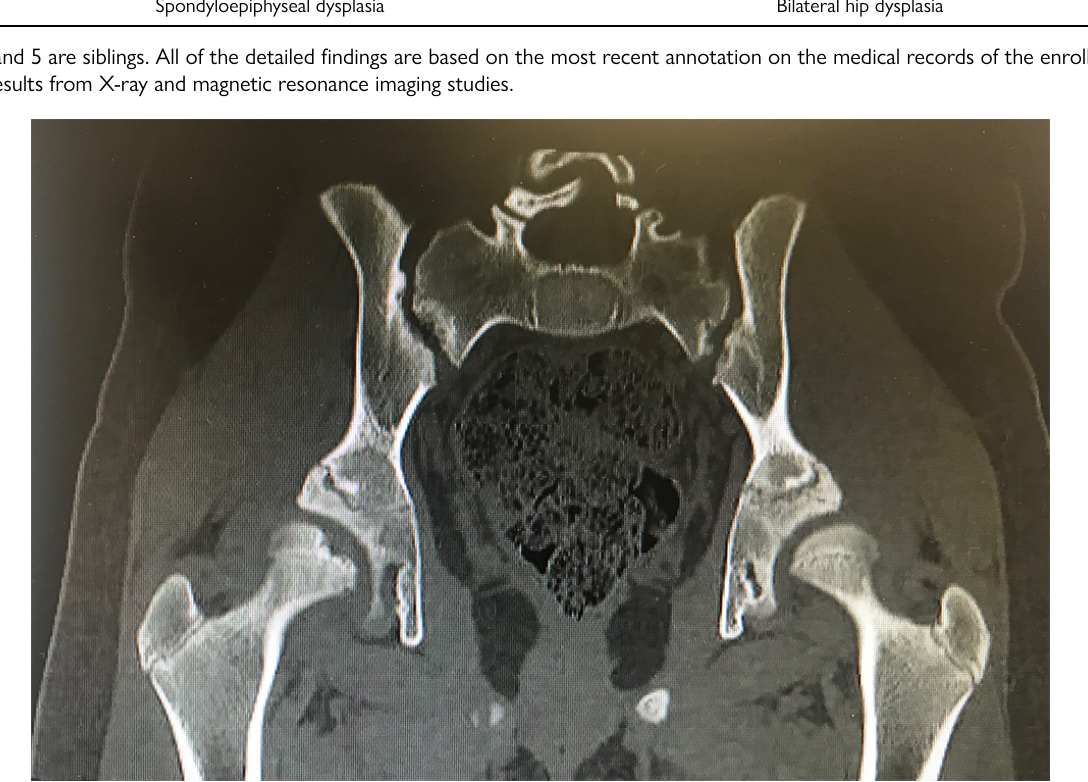
Figure 1. Computed tomography of hip from a female 16-year-old MPS VI patient (patient #1) with gait disturbance and pain showing hip dysplasia characterized by shallow and irregular acetabulum, triradiate cartilage enlargement and deficiency in the development of the acetabular superior